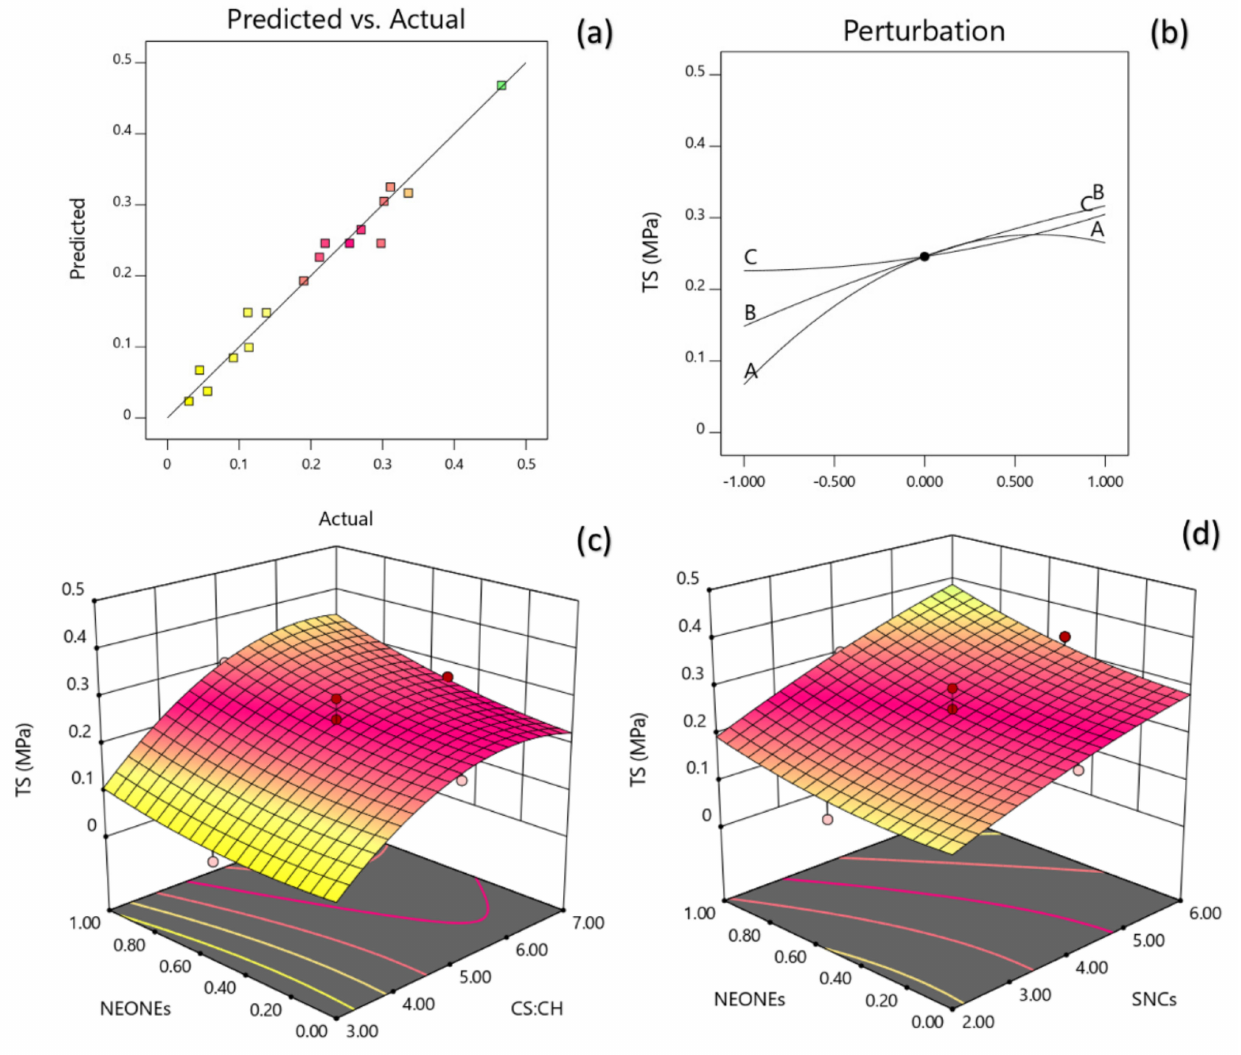
Figure 8. Counter and perturbation graphs ( a , b ), the interaction between CS:CH and SNCs concentration and also interaction between SNCs and NEONEs concentration on TS of the produced film ( c , d